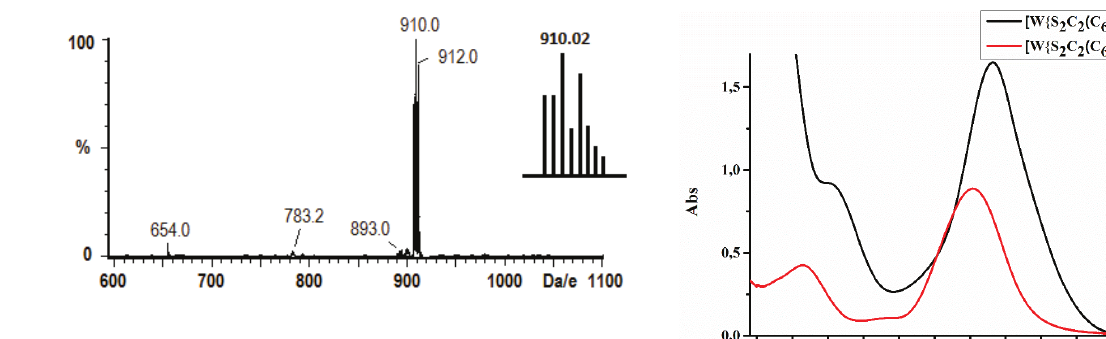
Figure 2: UV-Vis spectrum of complexes [W{S